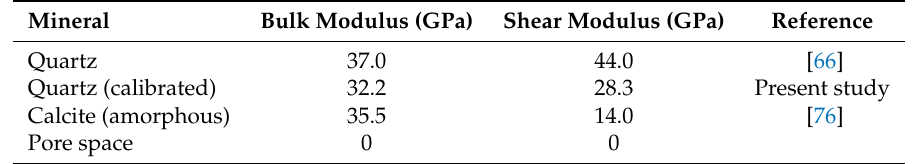
Table 1. Bulk and shear moduli for all minerals used to compute effective elastic rock